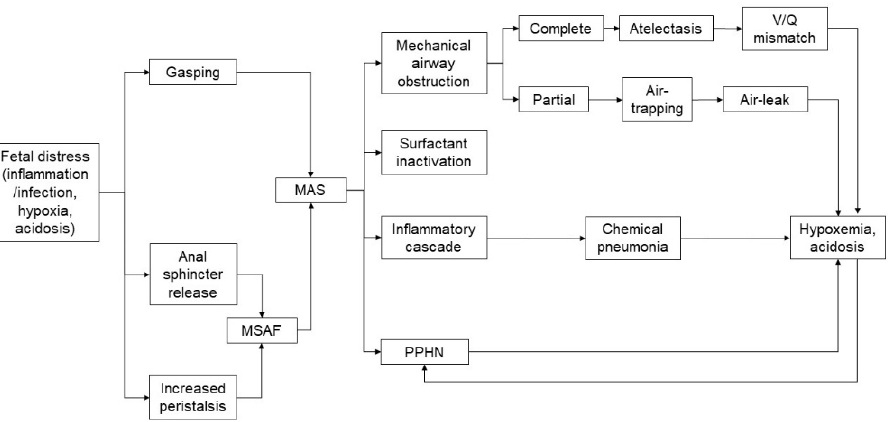
Figure 1. Pathophysiology of meconium aspiration syndrome (MAS). LEGEND: MAS, meconium aspiration syndrome; MSAF, meconium stained amniotic fluid; PPHN, persistent pulmonary hypertension of the neonate; V/Q mismatch, ventilation/perfusion mismatch.